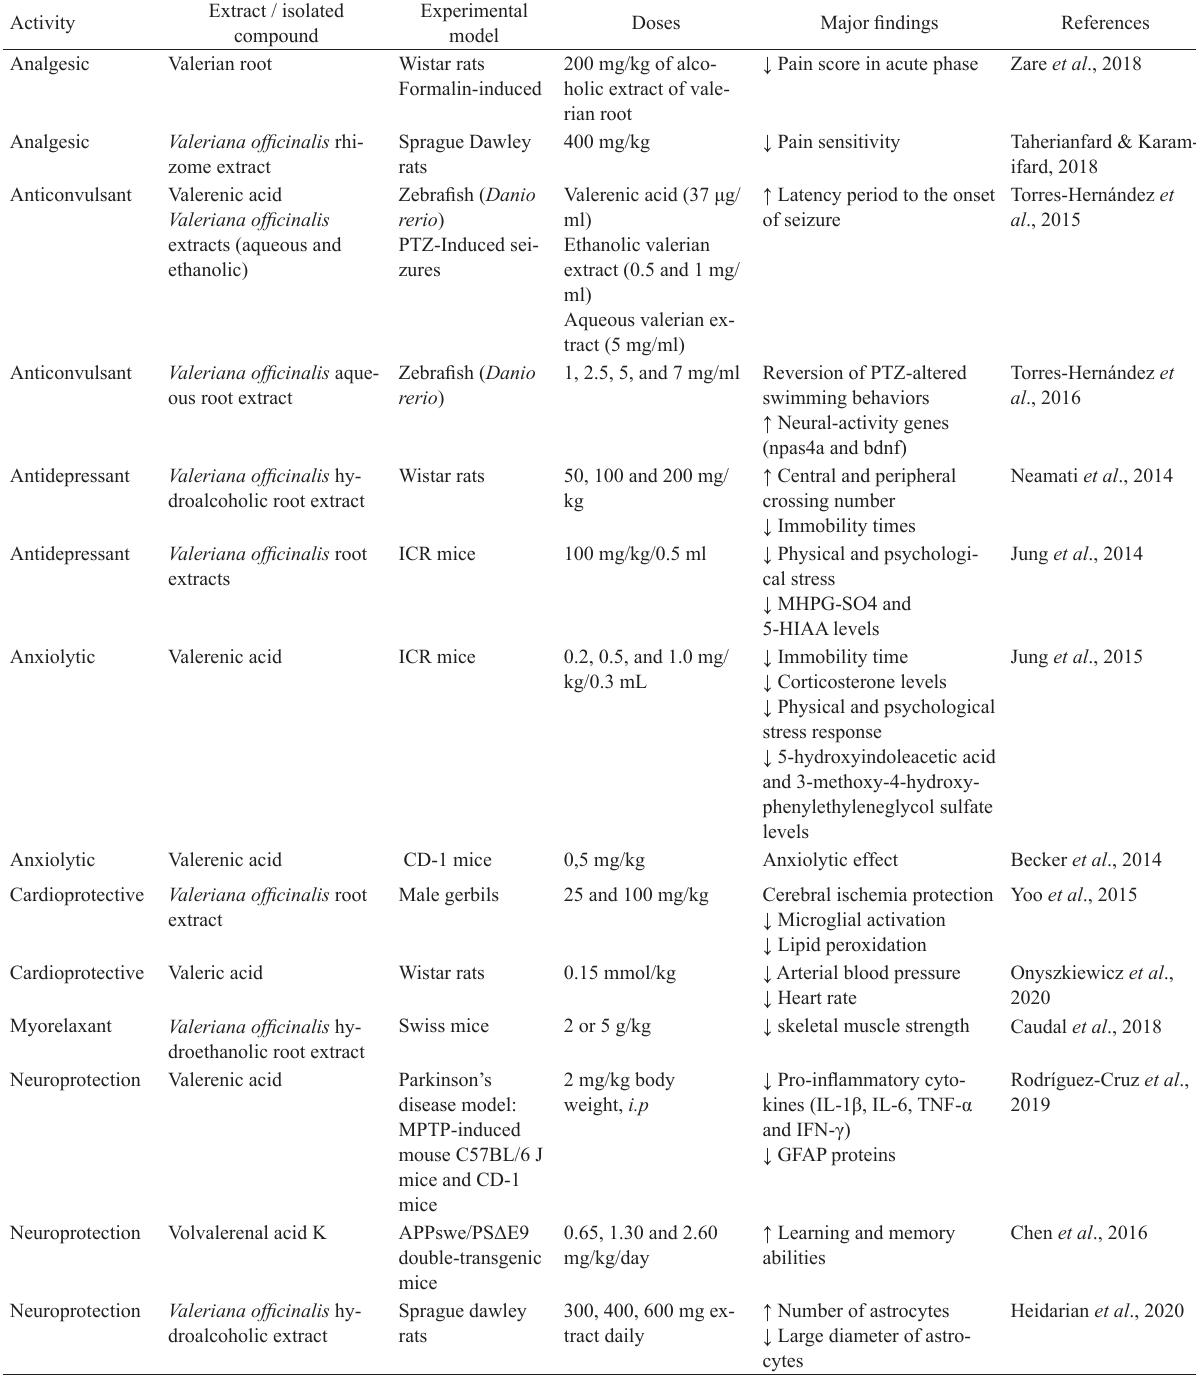
Table 2. In vivo biological studies for Valeriana officinalis